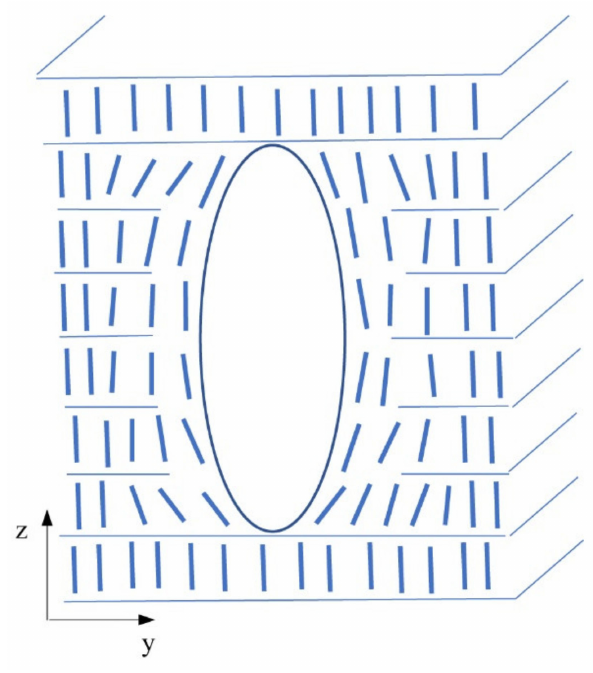
Figure 6. Schematic drawing in the plane ( y , z ) shows a nanoparticle cluster incorporated into the smectic layer system. The cluster in this scheme has an ellipsoidal profile along with the layer normal and is covered by a shell of disordered molecules influenced by the molecular interaction with the cluster’s surface. The cluster within the shell is enveloped by prismatic dislocation loops (not included in this figure, for the illustration see Figure